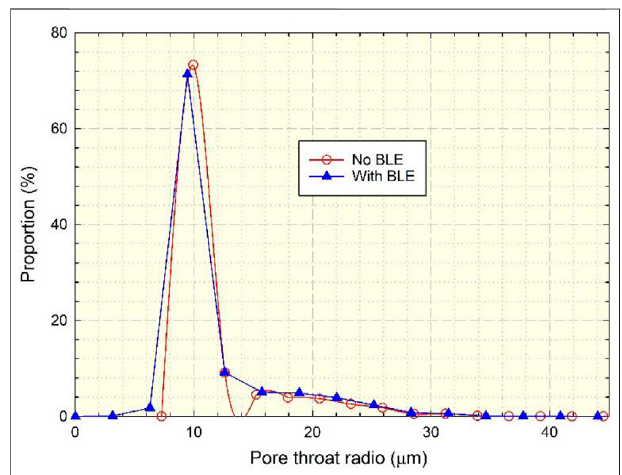
FIGURE 15 | Comparison of effective coordination numbers under BLE. FIGURE16| Comparison ofthedistributionoftheeffective throat radius